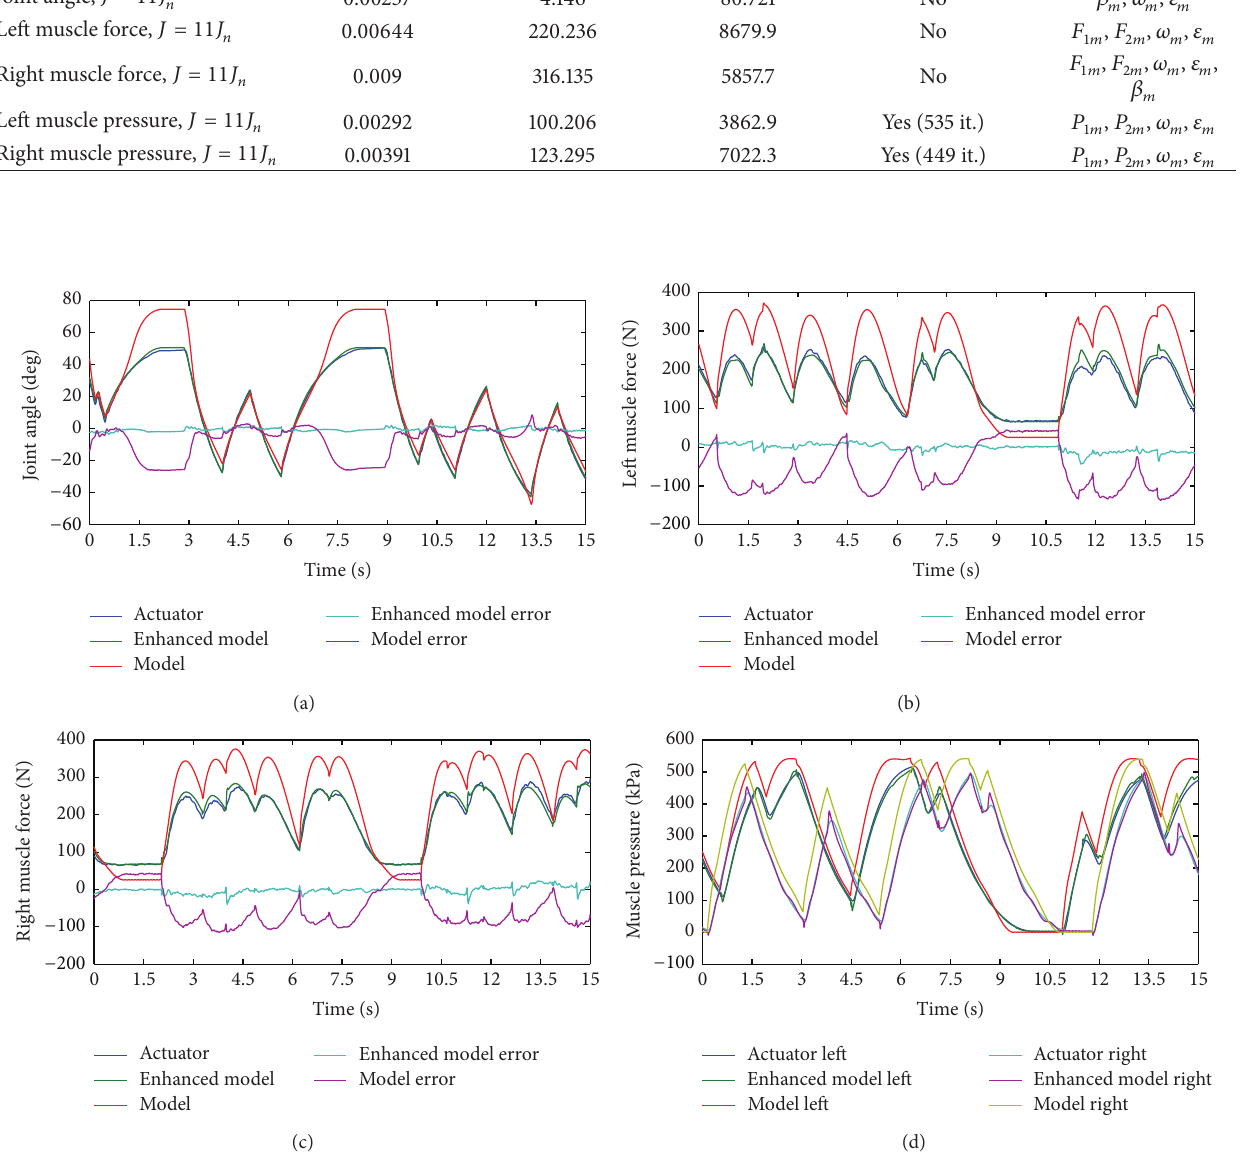
Figure 12: Comparison of model, enhanced model, and actuator generalization performance (test on unseen data with nominal of moment of inertia ((a) joint angle response, (b) left muscle force response, (c) right muscle force response, and (d) muscle pressure response in both